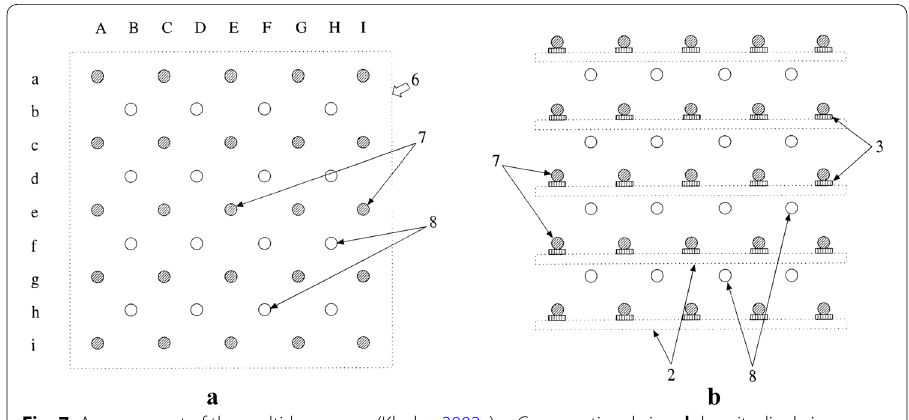
Fig. 7 Arrangement of the multi-layer warp (Khokar 2002c). a Cross sectional view, b longitudinal view. 2—heald shafts, 3—flat healds, 6—multi-layer warp, 7—active warp yarns, 8—passive warp yarns, A,C,E,G,I— columns of active warp yarns, B,D,F,H—columns of passive warp yarns, a,c,e,g,i—rows of active warp yarns, b,d,f,h—rows of passive warp